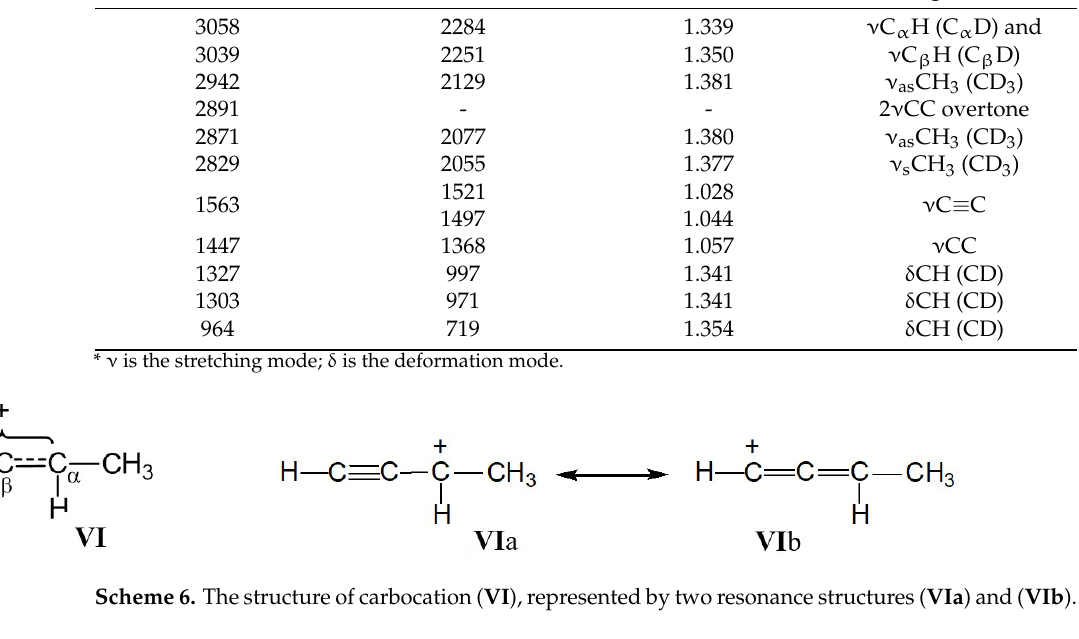
Table 6. IR spectra of C 4 H 5+ and C 4 D 5+ cations (isomers VI ) in their salts with the {Cl 11 − } anion. C 4 H 5+